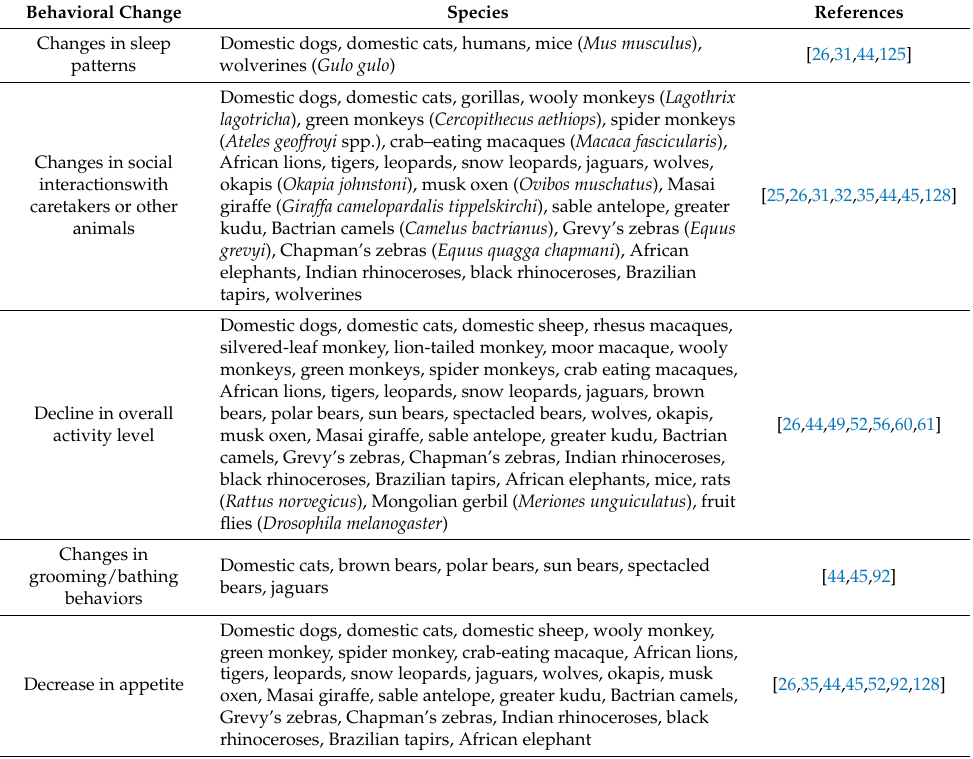
Table 2. Common behavioral changes described in ageing animals of different